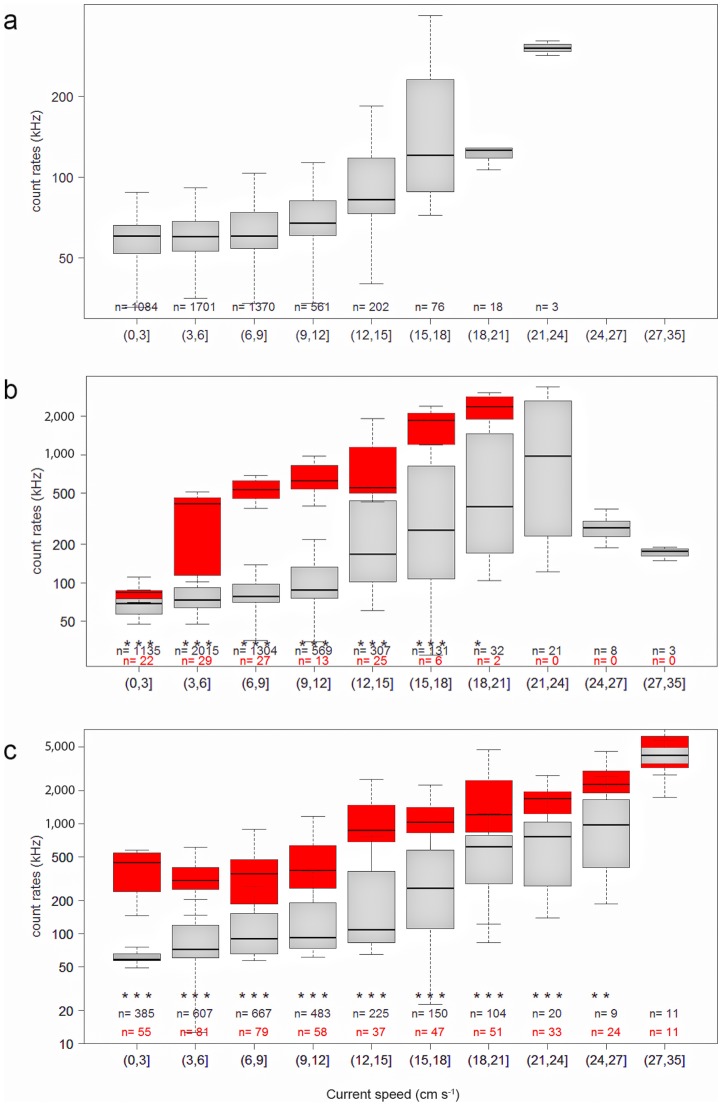
Links between bioluminescence, current speed and the modification of the properties of the Western Mediterranean Deep Water (WMDW).Box-and-whisker plot of median PMT counting rates (log scale) versus current speed classes for salinities higher (red) or lower (grey) than 38.479 for data recorded in (a) 2008, (b) 2009 and (c) between January and June 2010. The salinity threshold of 38.479 is used as a marker of the intrusion of newly formed deep water at the ANTARES site. While bioluminescence increases with current speed, it is also enhanced by the modification of WMDW (red box-plots). The top and bottom of each box-plot represent 75% (upper quartile) and 25% (lower quartile) of all values, respectively. The horizontal line is the median. The ends of the whiskers represent the 10th and 90th percentiles. Outliers are not represented. The statistical comparison between the two box-plots (red and grey) in each current class is given by the Kruskal-Wallis test: the observed difference between the two samples is significant beyond the 0.05 (*), the 0.01 (**) and the 0.001 (***) levels. The absence of an asterisk in some current classes indicates that the difference between the two box-plots is not significant. The number of measurements for salinity lower or higher than 38.479 is given in black or in red, respectively. Note the different scales of figures a, b and c.